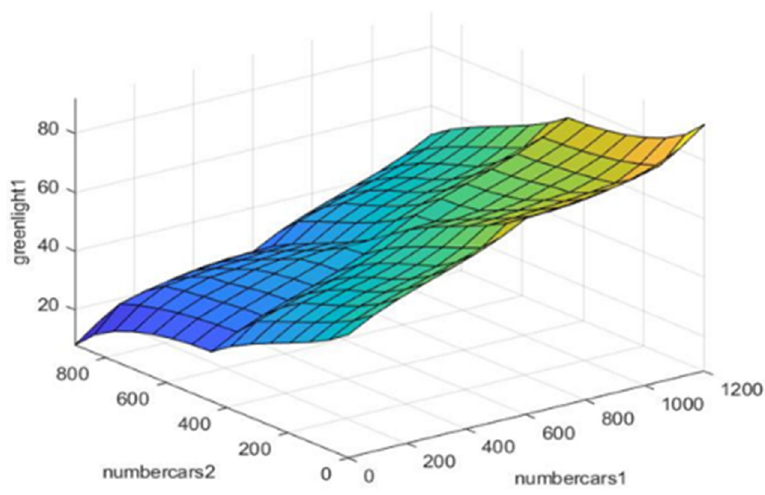
Figure 5. Surface of the fuzzy controller with one output and two inputs for junction 1.